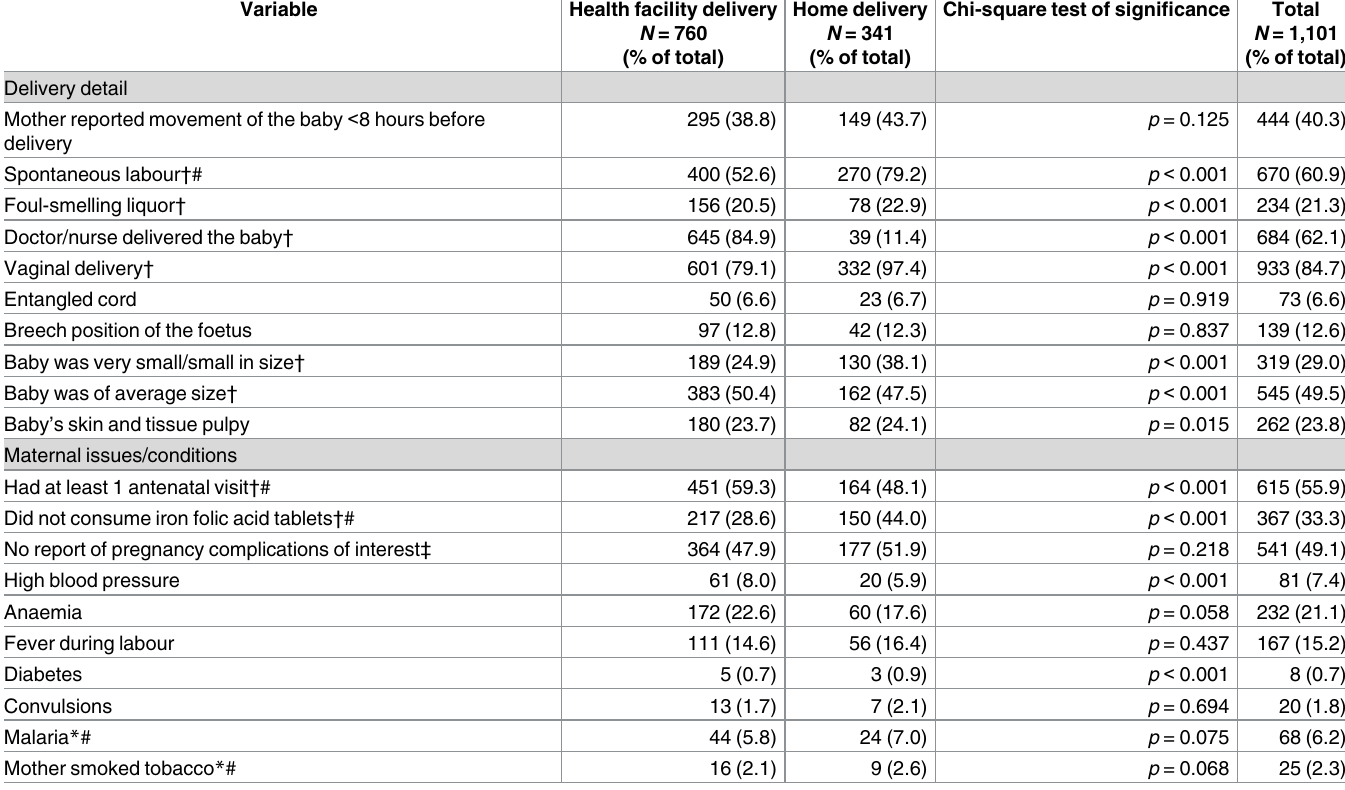
Table 2. Variation in the distribution of delivery-related variables and associated maternal conditions for stillbirths between January 2011 and March 2014in the Indian state of Bihar. Twenty-six deliveries that occurred en route to the hospital are includedunder healthfacility delivery.Place of deliv- ery was not available for 2